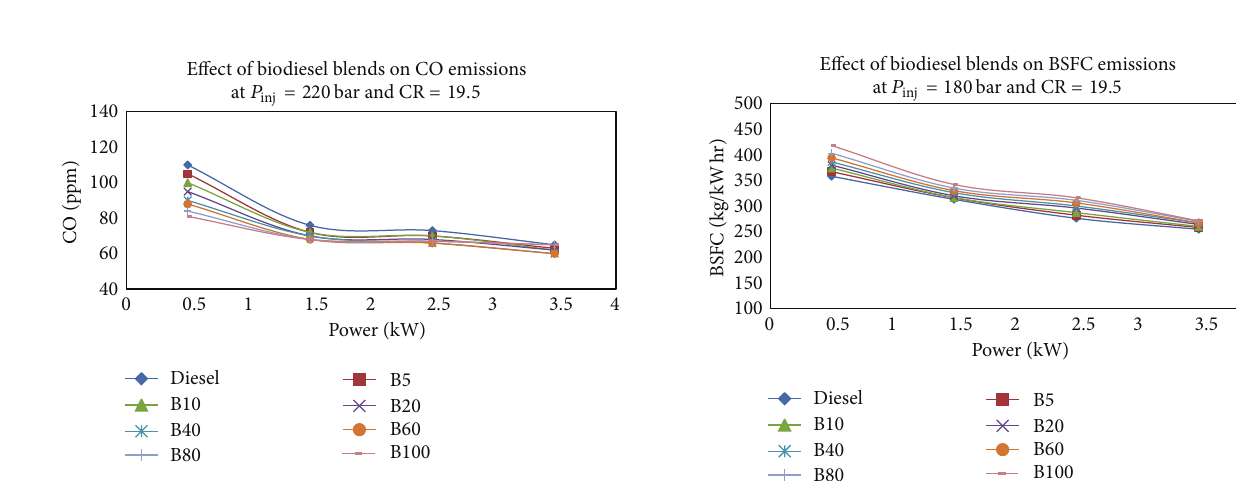
Figure 20: Variation in CO for various biodiesel blends at 𝑃 180bar and CR 19.5.